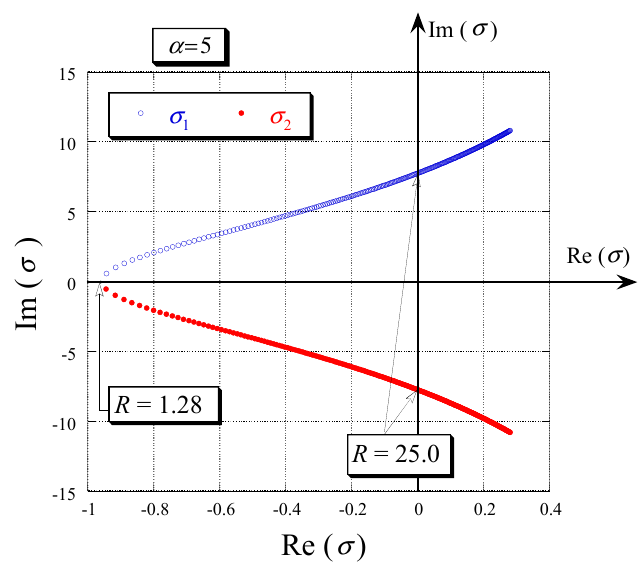
Figure 3. Variation of the eigenvalues as the value of R increases [8,21]. (Reproduced with permissions from Peter Vadasz, Shmuel Olek, Transport in Porous Media; published by Springer, 1999. Peter Vadasz, Journal of Porous Media; published by Begell House,